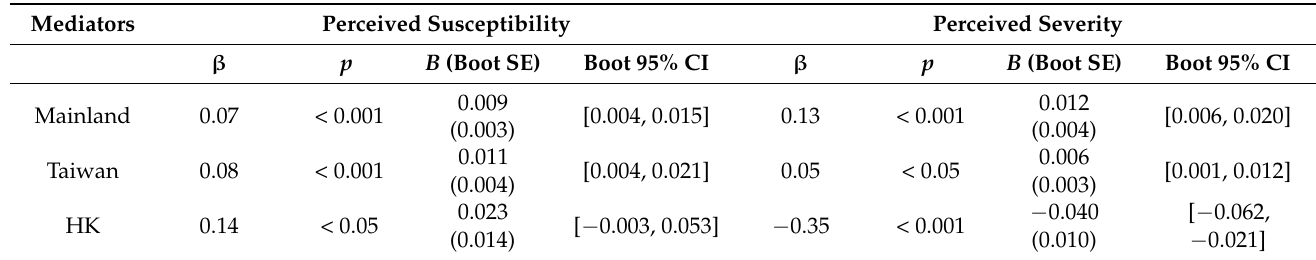
Table 3. Testing the mediating effect of perceived threat on vaccination intention.